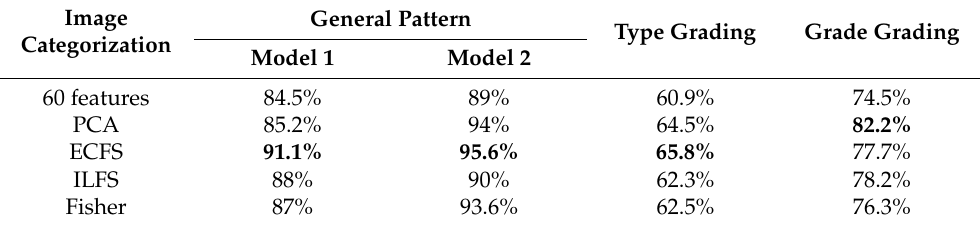
Table 6. Testing accuracy results using 30 most significant hand-crafted